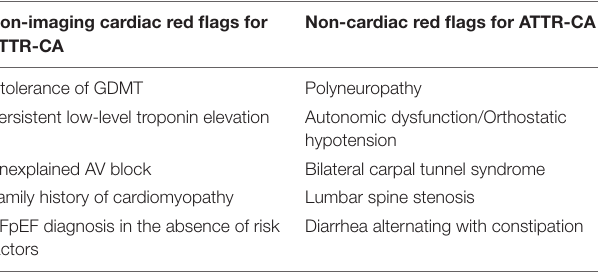
Non-cardiac red flags for ATTR-CA